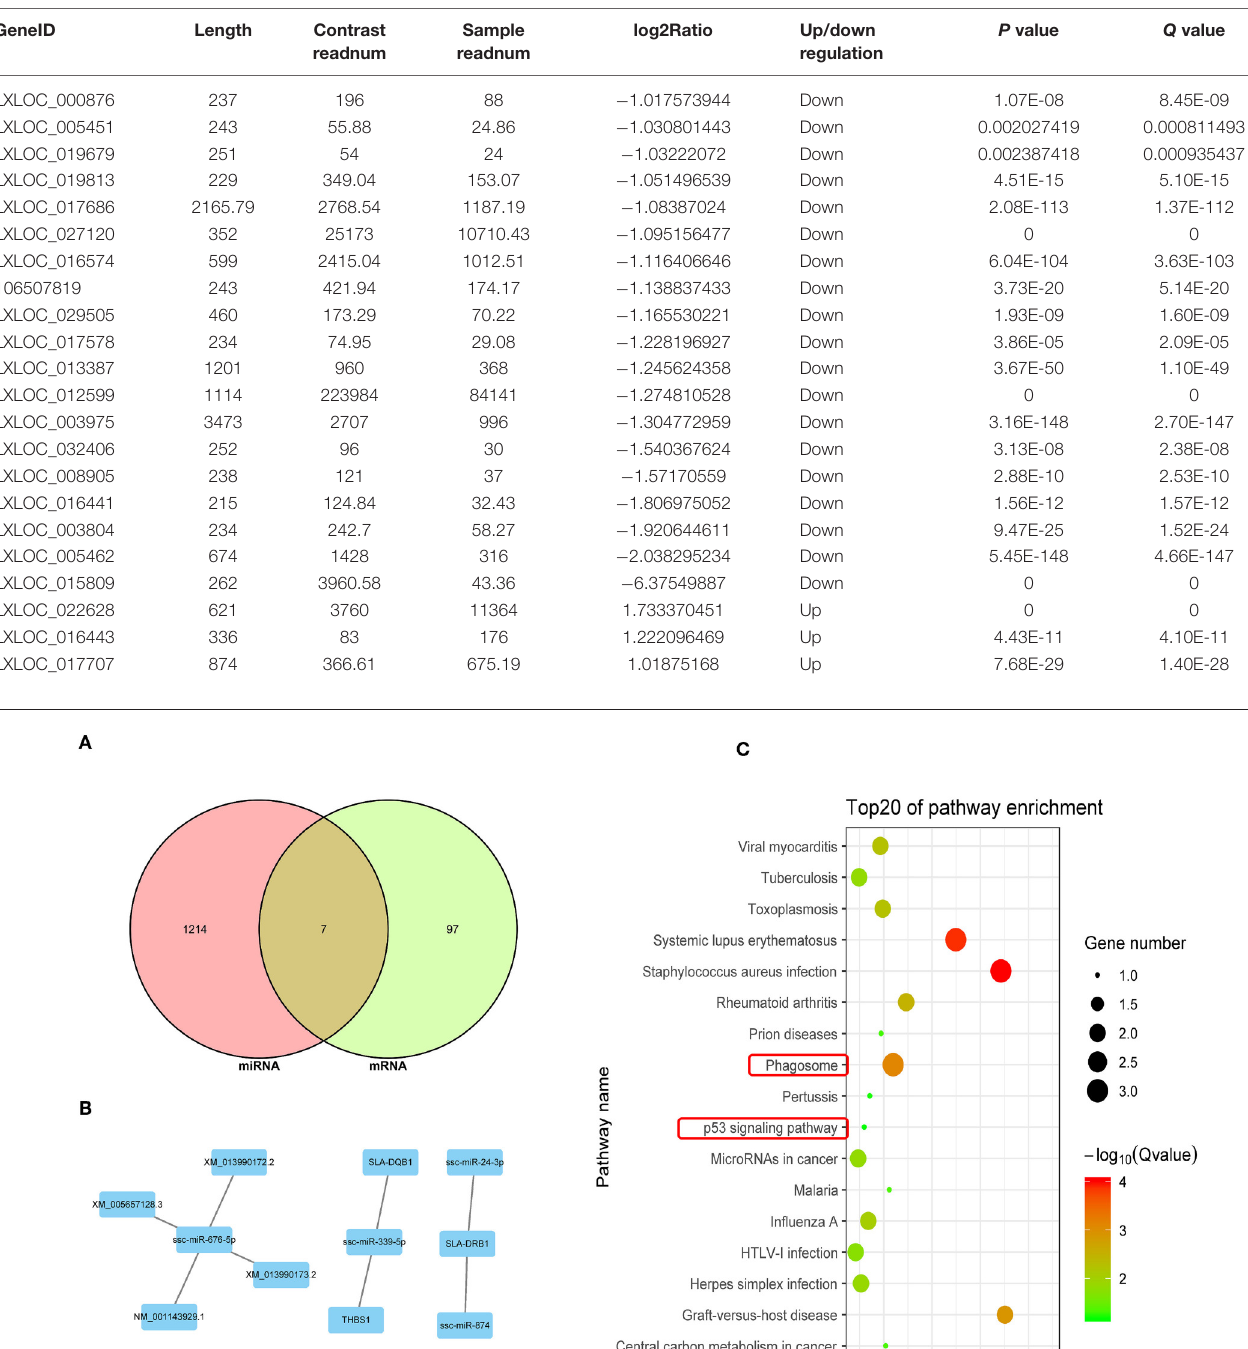
Frontiers in Immunology |